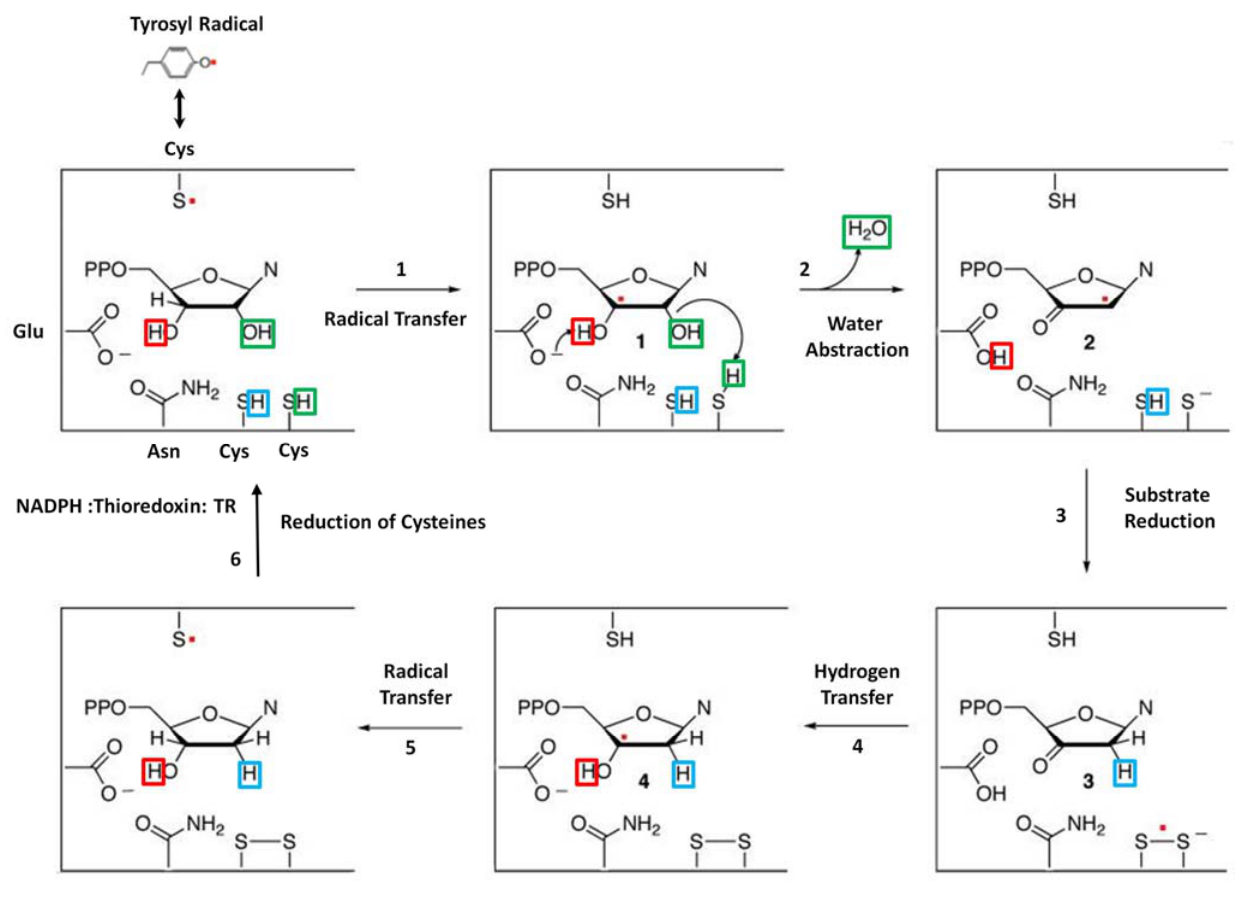
Figure 2. Catalytic Mechanism of Class Ia RR. See the text for a detailed description of the mechanism. Adopted from Zipse et al. [51] and modified. Copyright (2009) American Chemical